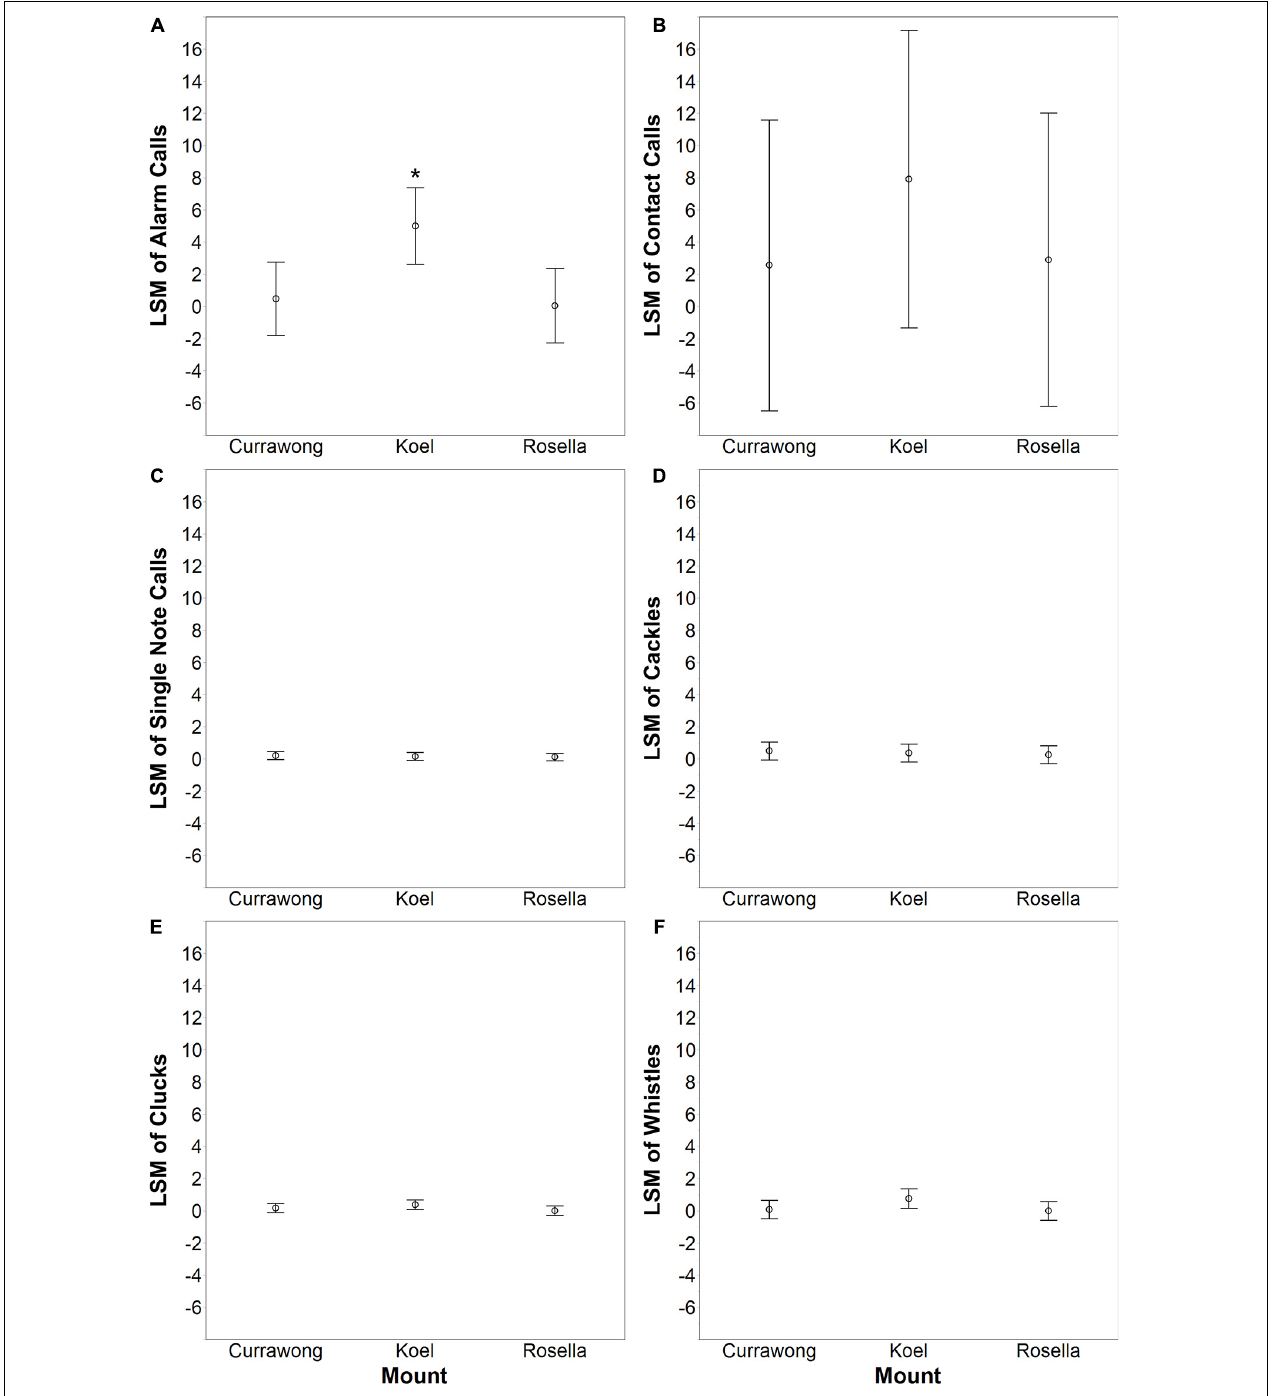
FIGURE 2 | The least square means (LSM) ± 95% CI from six ( A–F ) REMLs where the number of calls given for each call type during a trial was the response variable, nest ID was the random effect and the type of mount (koel, currawong and rosella) was the independent variable. An asterisk indicates a significant difference between treatments (Tukey HSD, P <